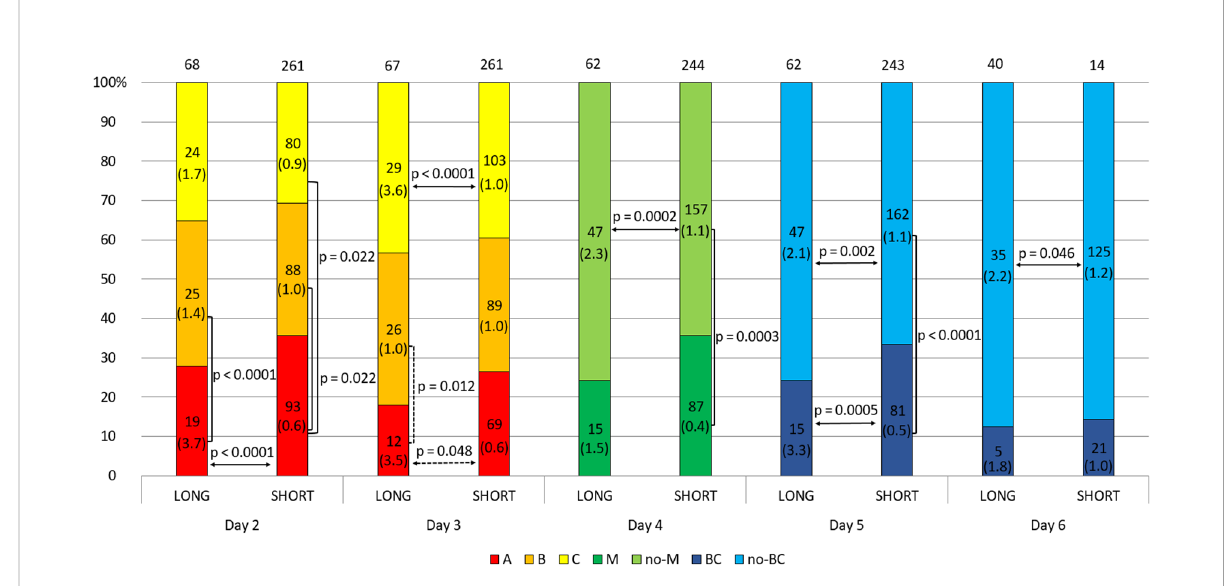
FIGURE 3 Effect of embryo quality on the concentration of secreted HLA-G in the long and short stimulation protocol. 1) development of embryos over time from the second to the sixth day (height of the colored stripes); 2) secretion comparisons between long and short protocol groups (horizontal arrows); 3) comparisons of secretion between embryos of different classes or stages of development (vertical clamps). A, B, C – class of the embryo, M – embryo in the morula stage; no-M – embryo that has not reached the morula stage; BC – embryo in the blastocyst stage; no-BC – embryo that has not reached the blastocyst stage. Median concentration of sHLA-G was presented in brackets. Dashed line – p-value resulting from analyses with insuf fi cient number of embryos. P-values are calculated by Mann-Whitney test or